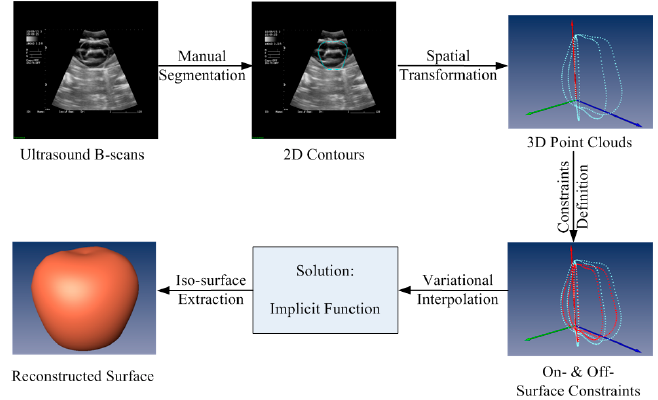
Figure 2. Framework of surface reconstruction of freehand 3D US using VSR.